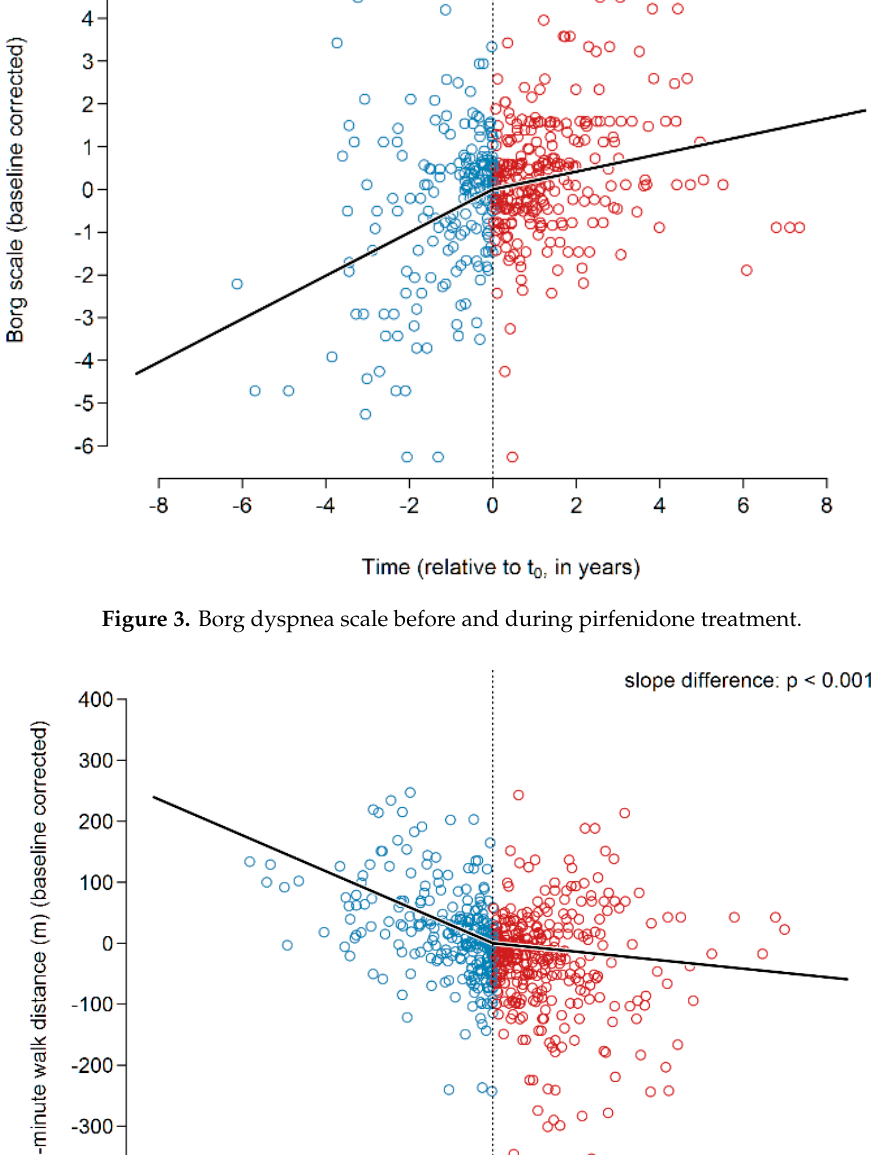
Figure 4. 6MWD before and during pirfenidone treatment. Abbreviations: 6MWD—six-minute walking distance.